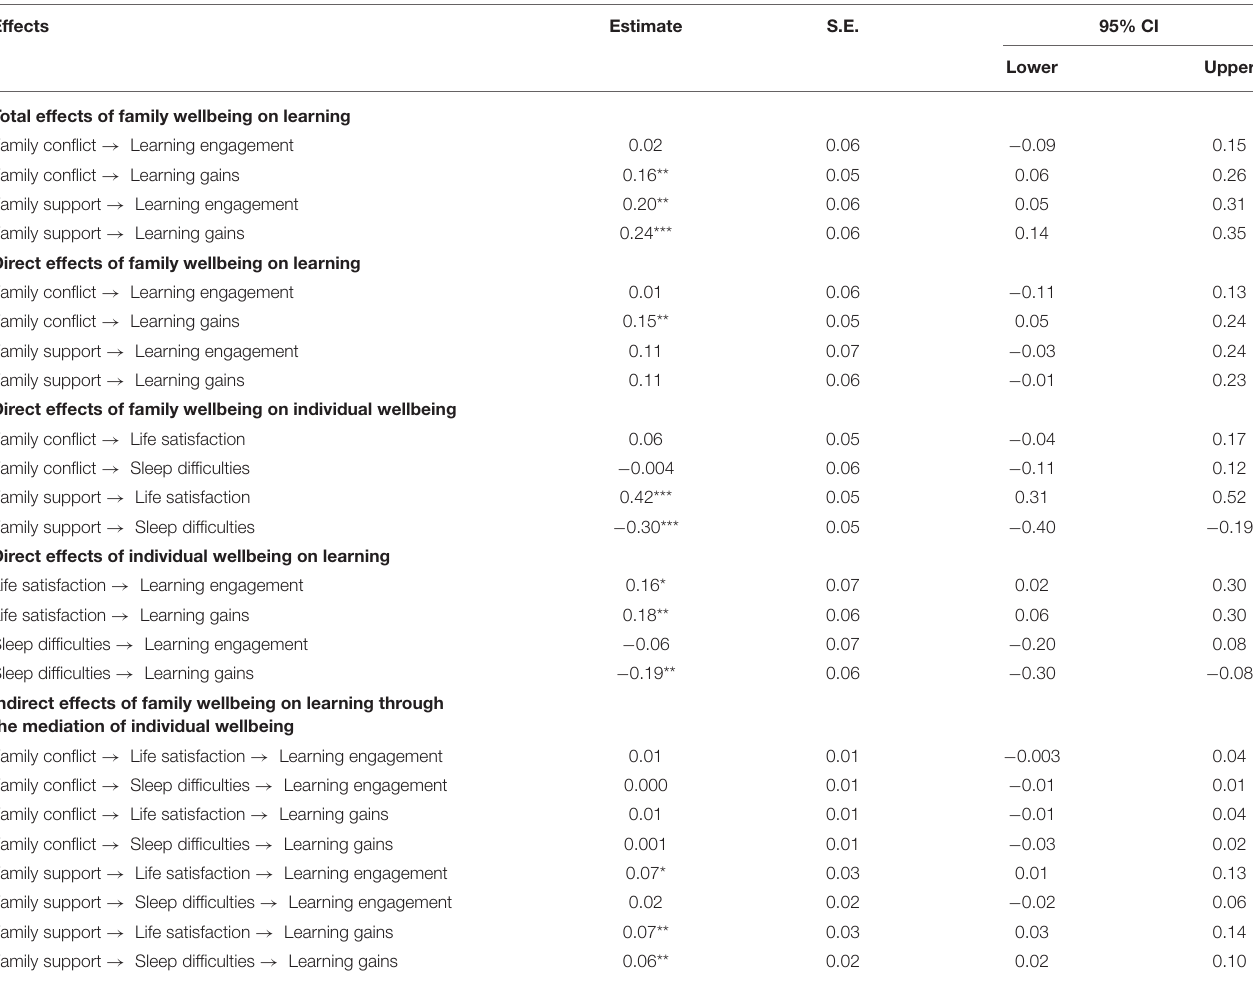
TABLE 2 | Standardized effects with confidence intervals in the conceptual